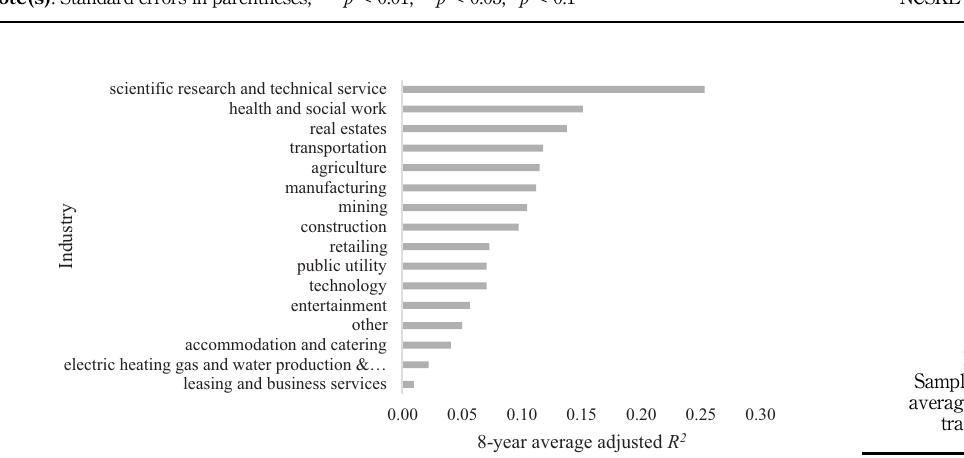
Table 4. Regression result of